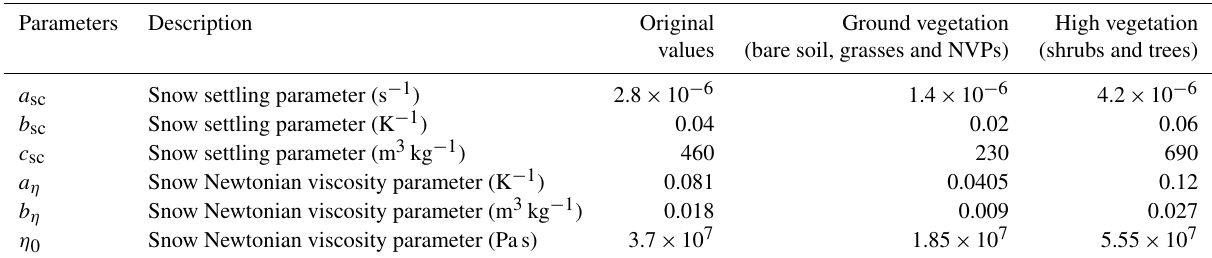
Table 3. Snow compaction parameters. Original values are from Wang et al. (2013), and herbaceous and high vegetation values are chosen to stay in the value range proposed by Wang et al.